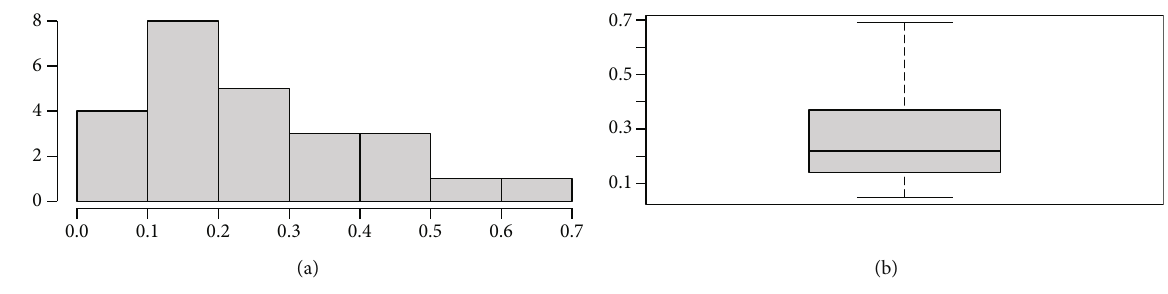
Figure 1: The histogram and box plot of peak ground acceleration data. Table 4: The values of the Kolmogorov-Smirnov goodness of fi t test for WIG, IG, and LN